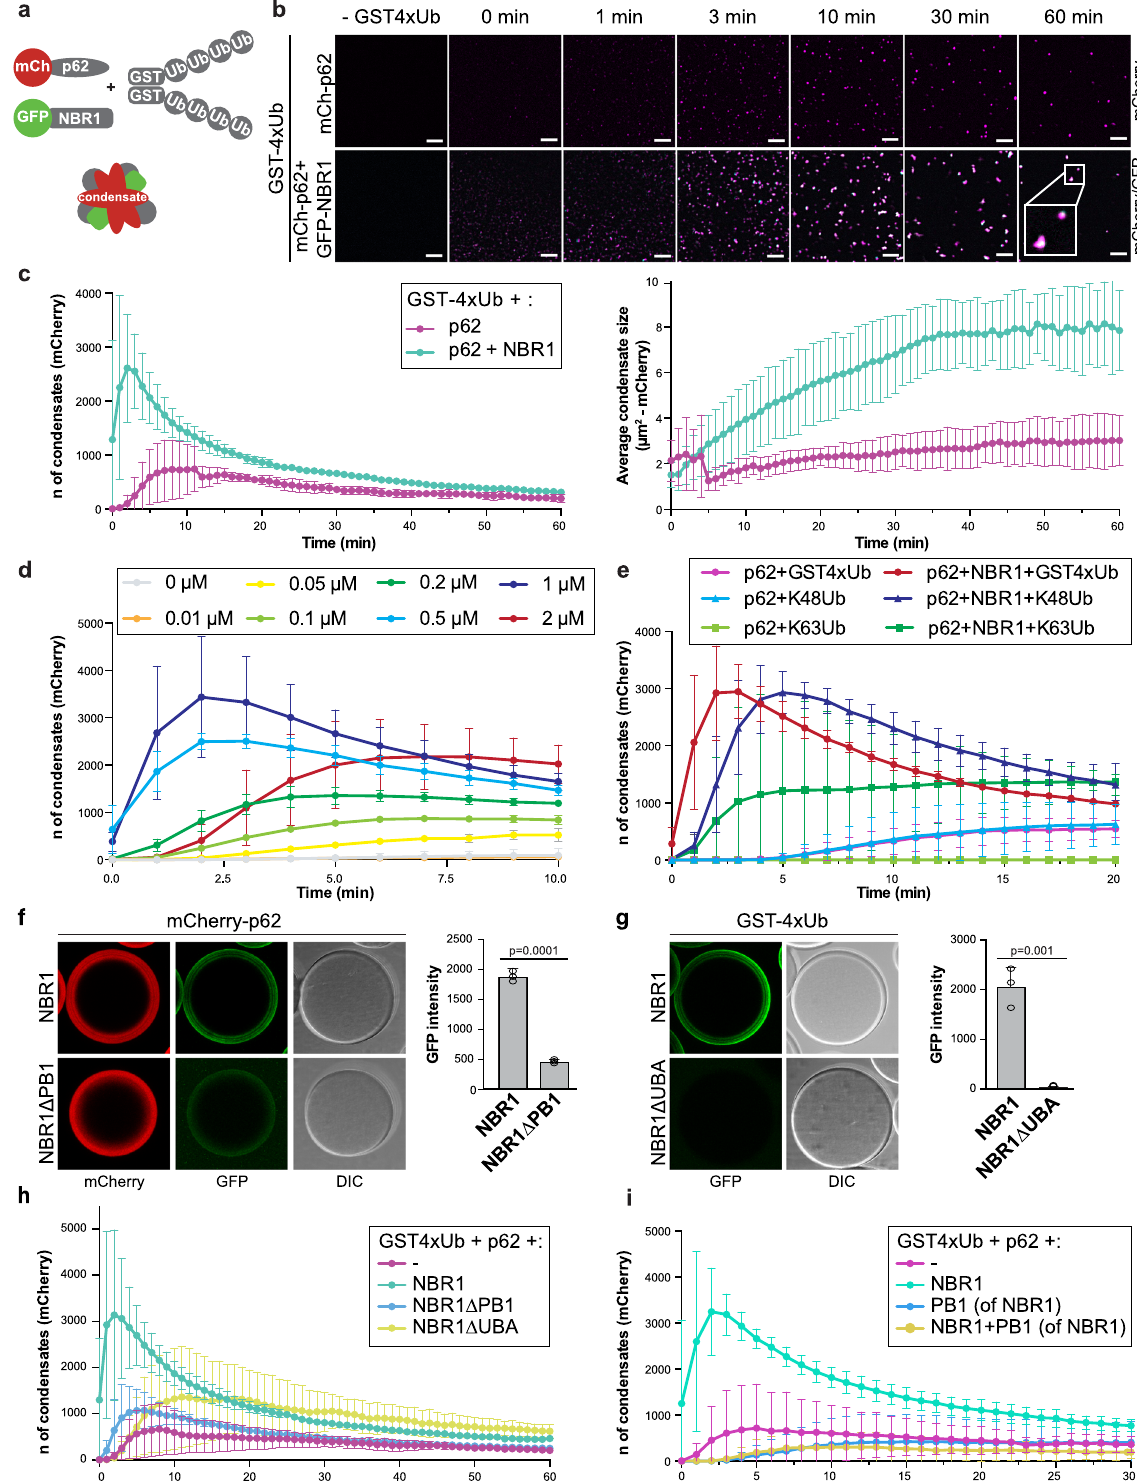
(Fig. 2h and Supplementary Fig. 2f, g). The PB1 domain alone did not promote condensation and in fact showed a dominant- negative effect on the reaction (Fig. 2i and Supplementary Fig. 2h). This suggests that the interaction of the NBR1 PB1 domain with p62 is not suf fi cient for the promotion of condensate formation but that this interaction mediates the recruitment of another biochemical activity of NBR1 to the